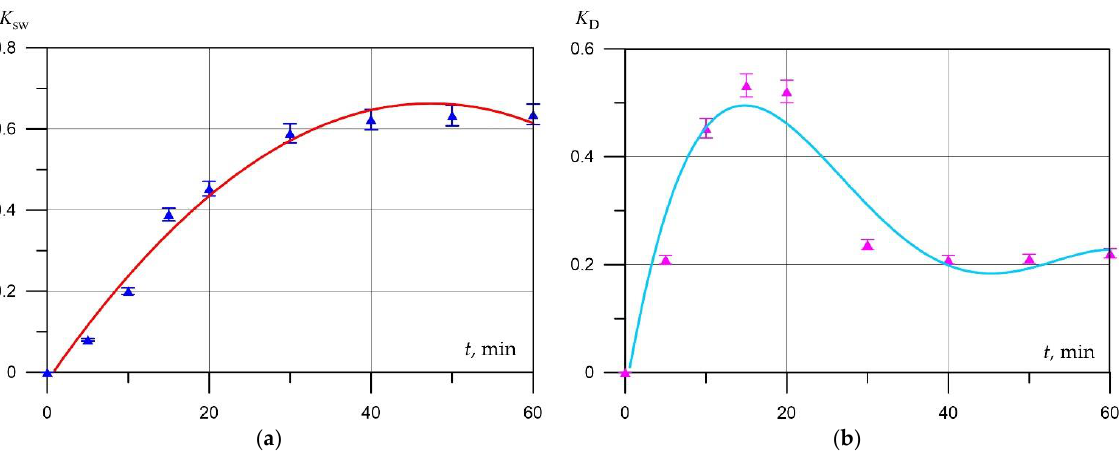
Figure 7. Kinetics of ( a ) swelling of mixture; ( b ) gas diffusion from a mixture, with pre-hydrated cement.